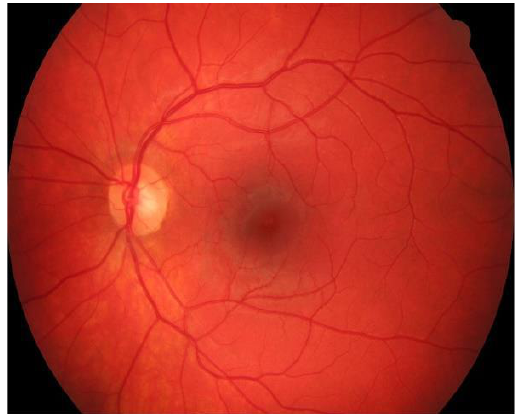
Figure 2.a. Original input image